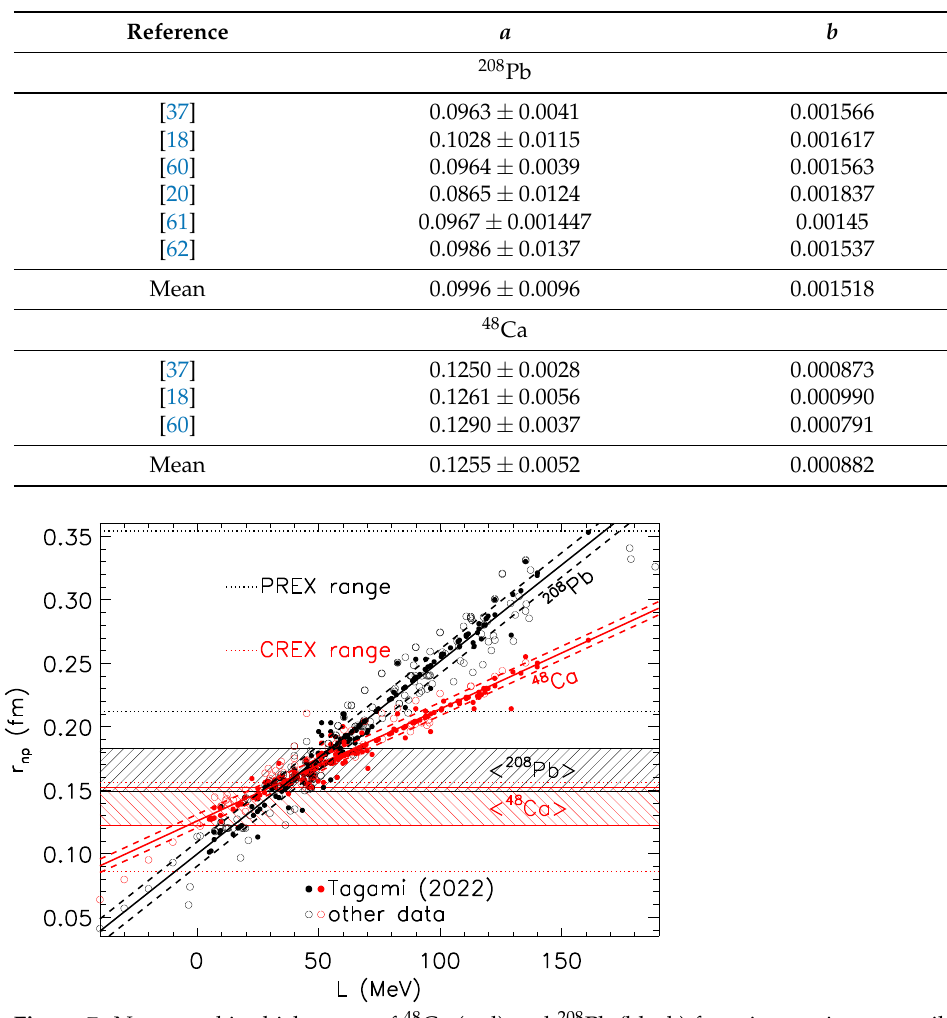
Table 3. Slopes, intercepts, and standard deviations of linear fits r np /fm = a ± ∆ a + bL /MeV.